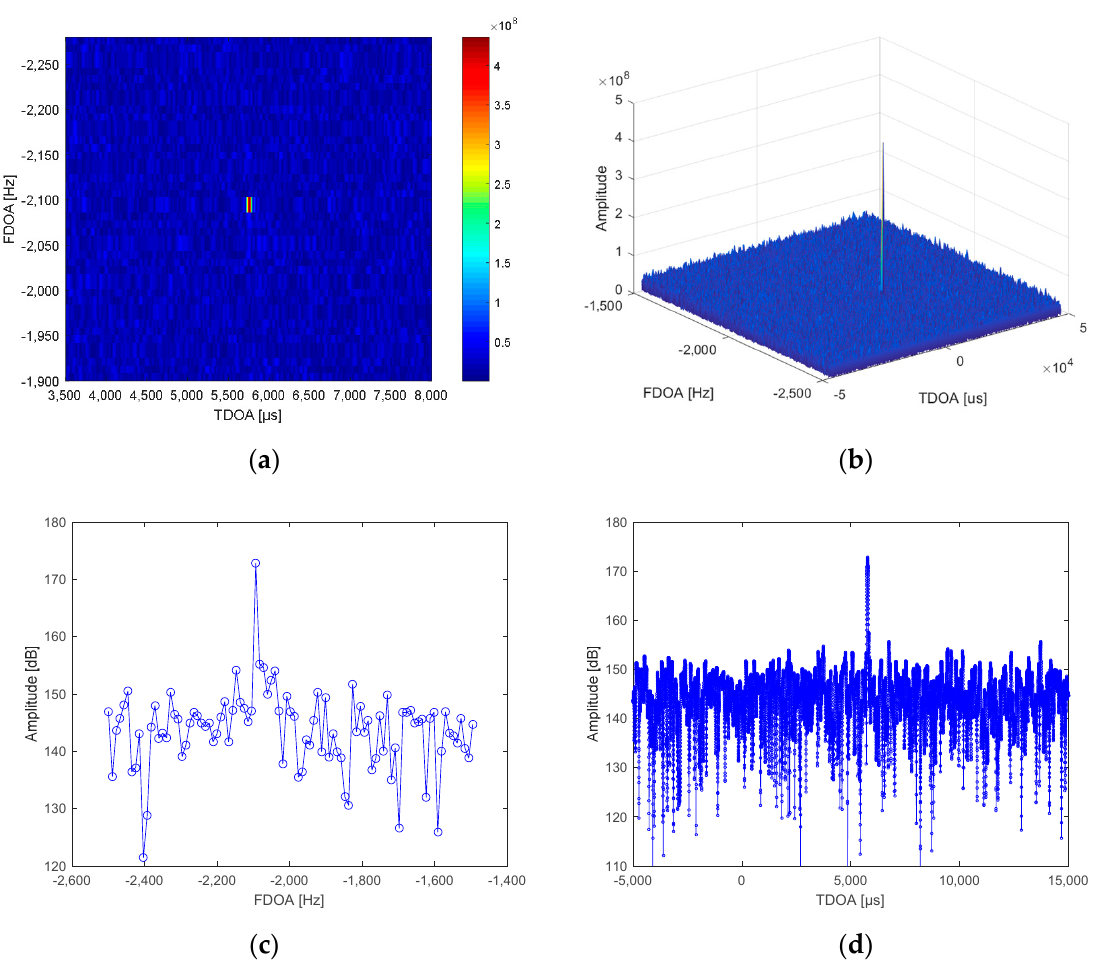
Figure 7. Results of the CAF processing using the real data in actual tests. ( a ) The CAF processing result in TDOA-FDOA plane; ( b ) the mesh of the CAF processing results in TDOA-FDOA; ( c ) the FDOA slice of maximum CAF amplitude; ( d ) the TDOA slice of maximum CAF